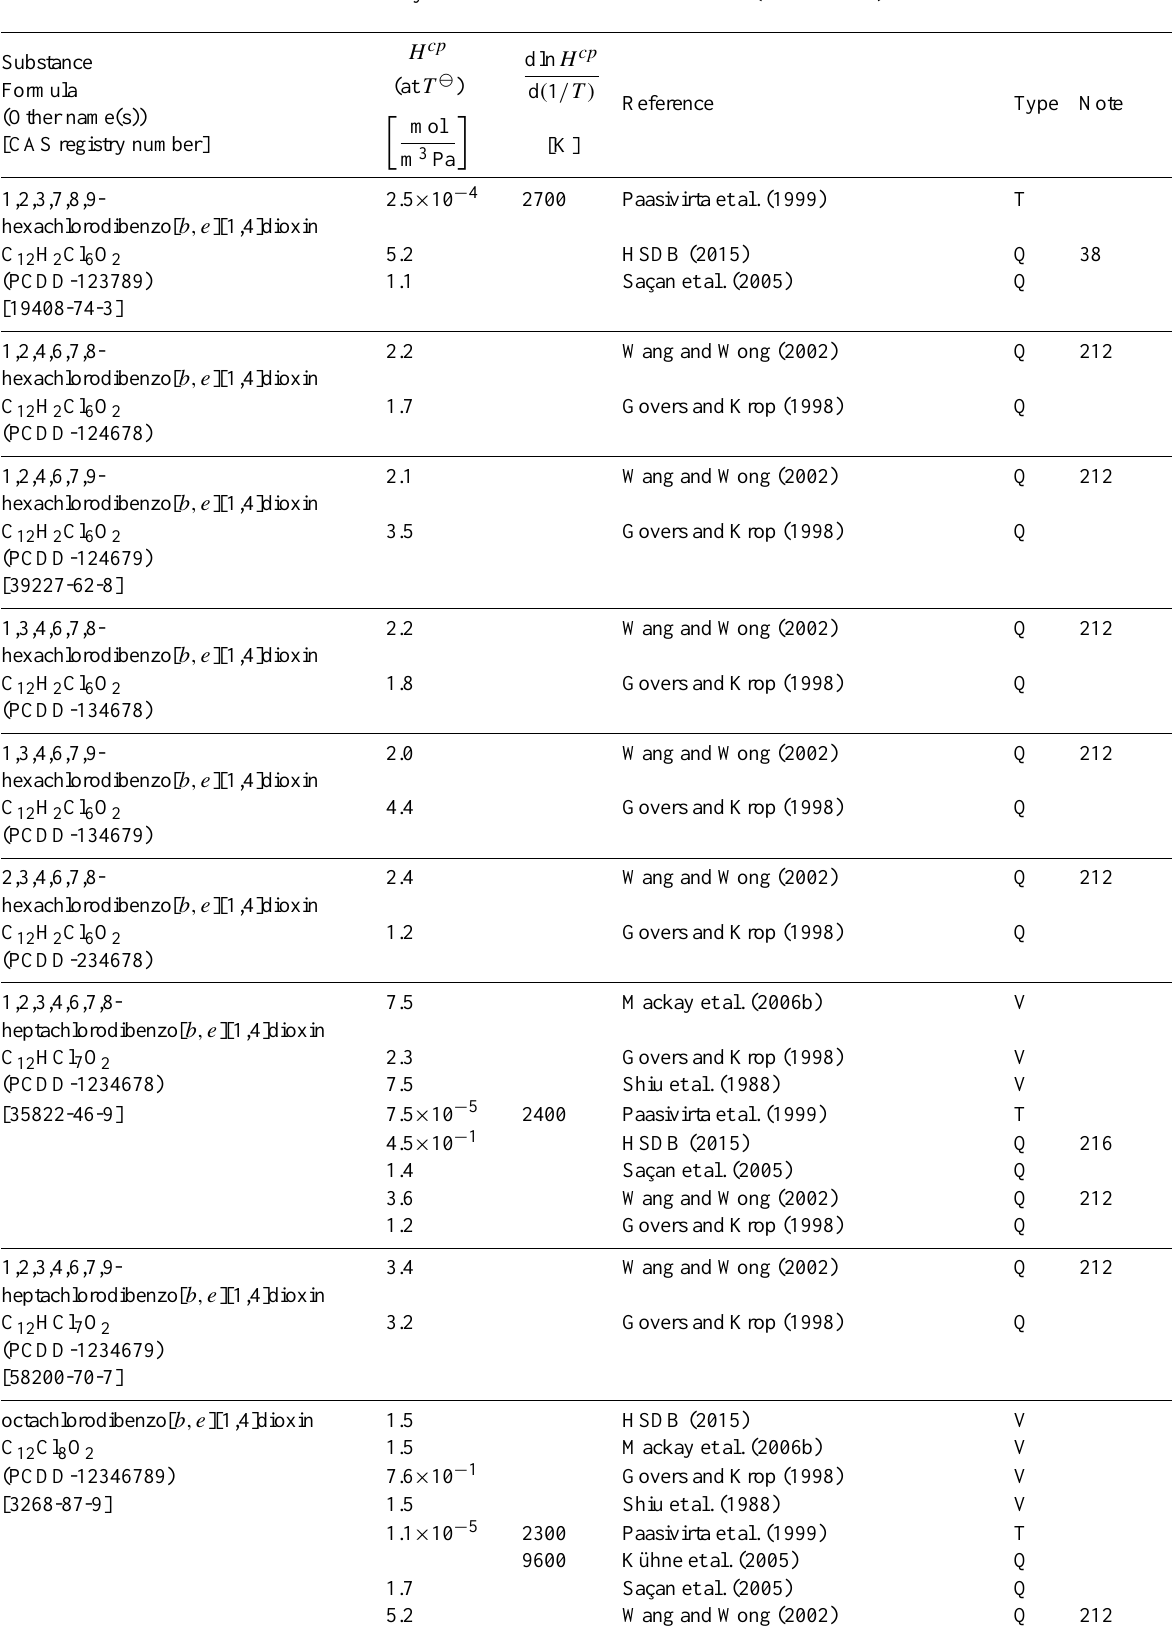
Table 6: Henry’s law constants for water as solvent